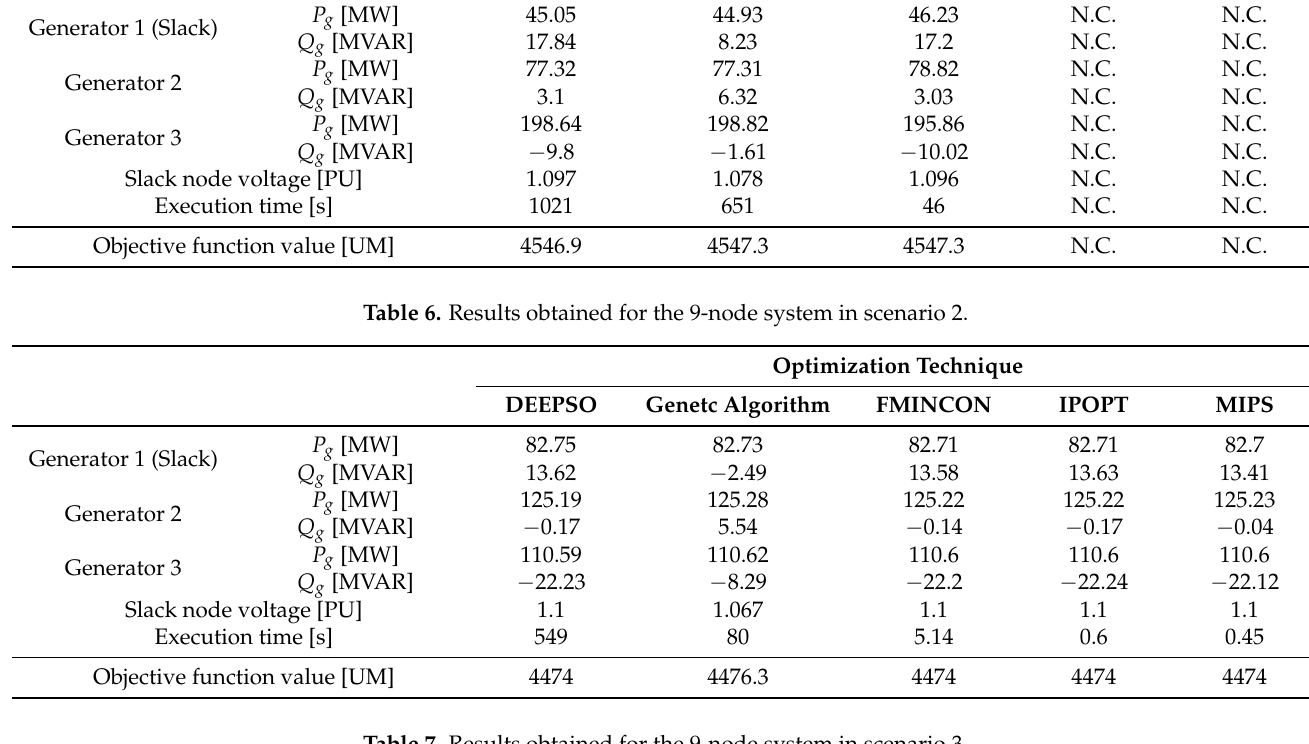
Table 7. Results obtained for the 9-node system in scenario 3.